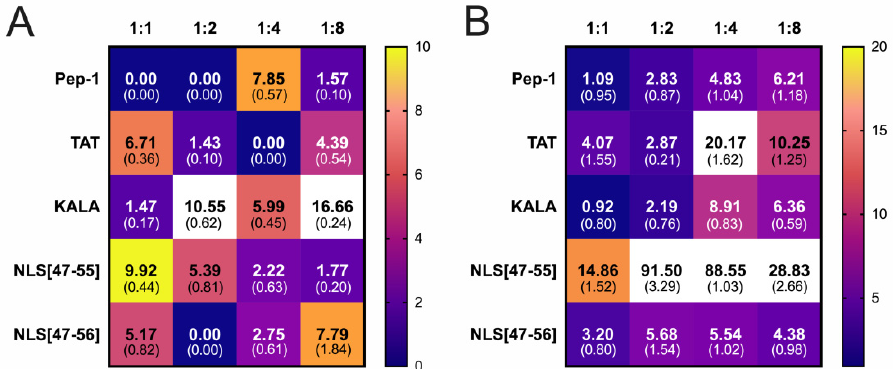
Figure 10. Results of 24 h culture in the presence of complexes in CRs of 1:1, 1:2, 1:4 and 1:8. The complexes were formed using incubation of 2 μ g pmaxGFP with chosen CPPs at 21 °C for 30 min. Bar = 50 μ m. CR, charge ratio.